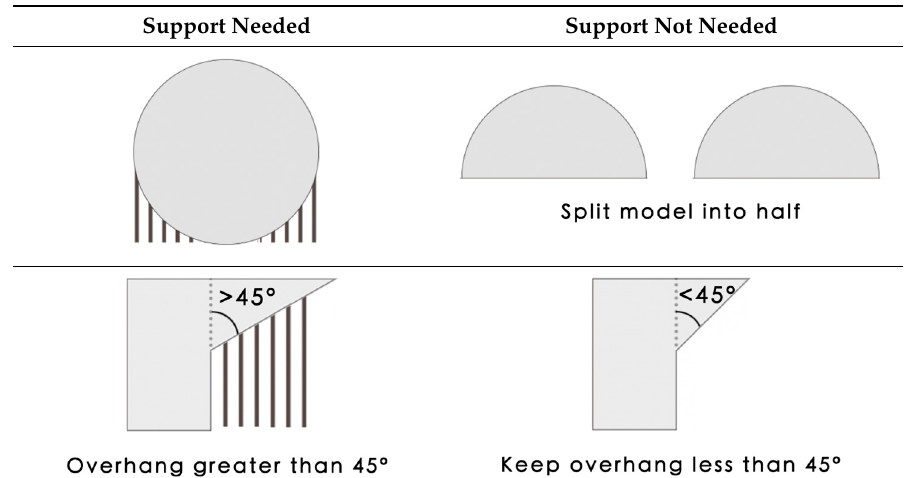
Table 5. Strategies to avoid support structure.